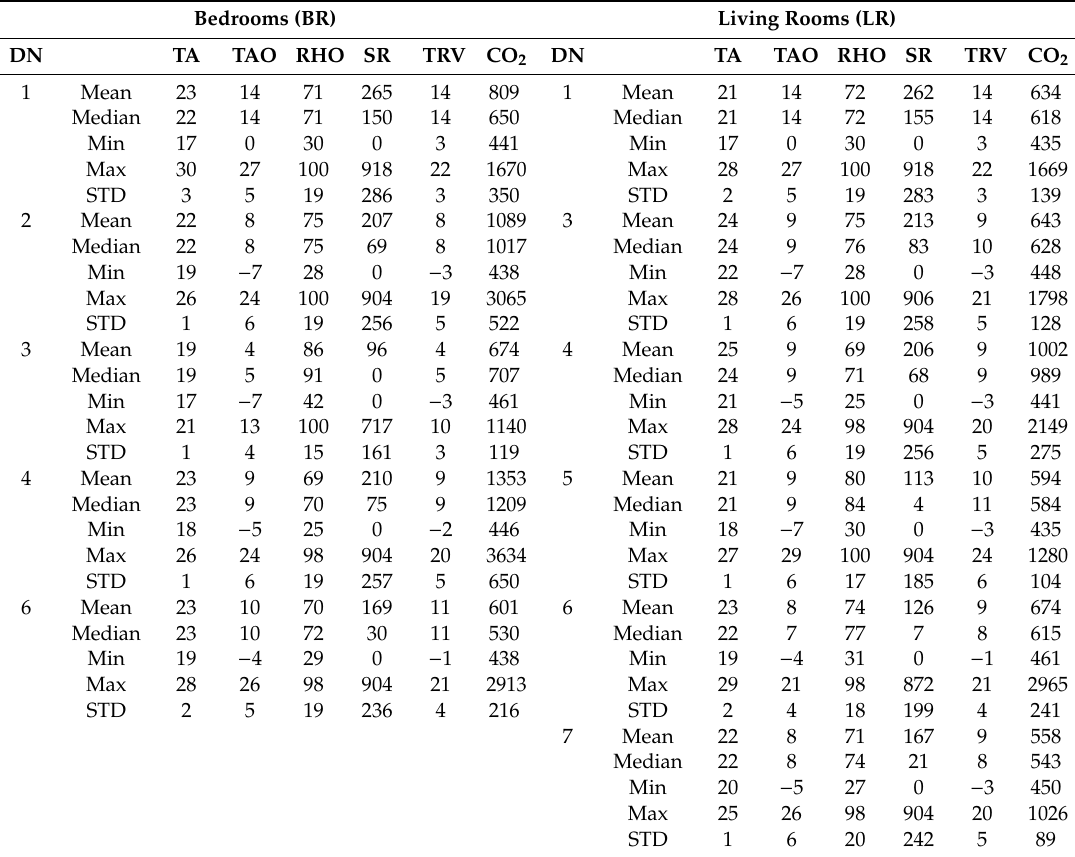
Table 5. Main descriptive statistical parameters of the monitored variables used as input parameters for the TA prediction algorithm. STD: Standard deviation. DN: Dwelling number.